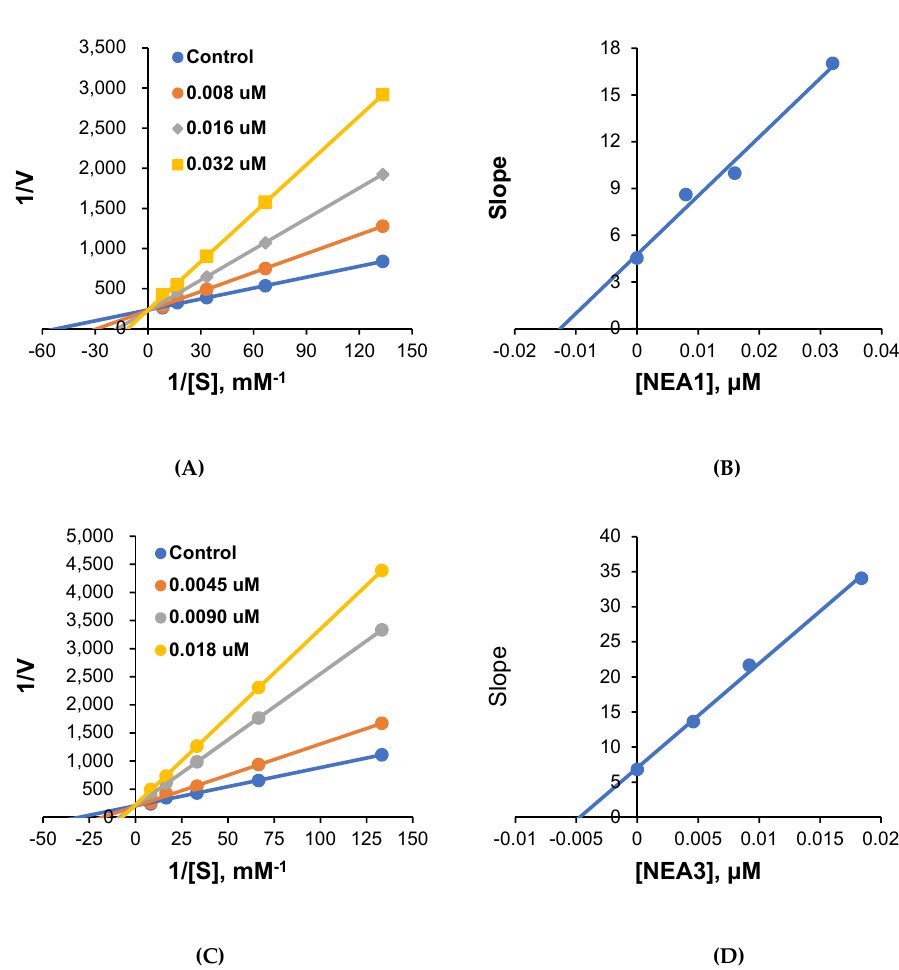
Figure 1. Lineweaver–Burk plots for MAO-B inhibition by NEA1 and NEA3 ( A , C ), and their respective secondary plots ( B , D ) of the slopes vs. inhibitor concentrations.